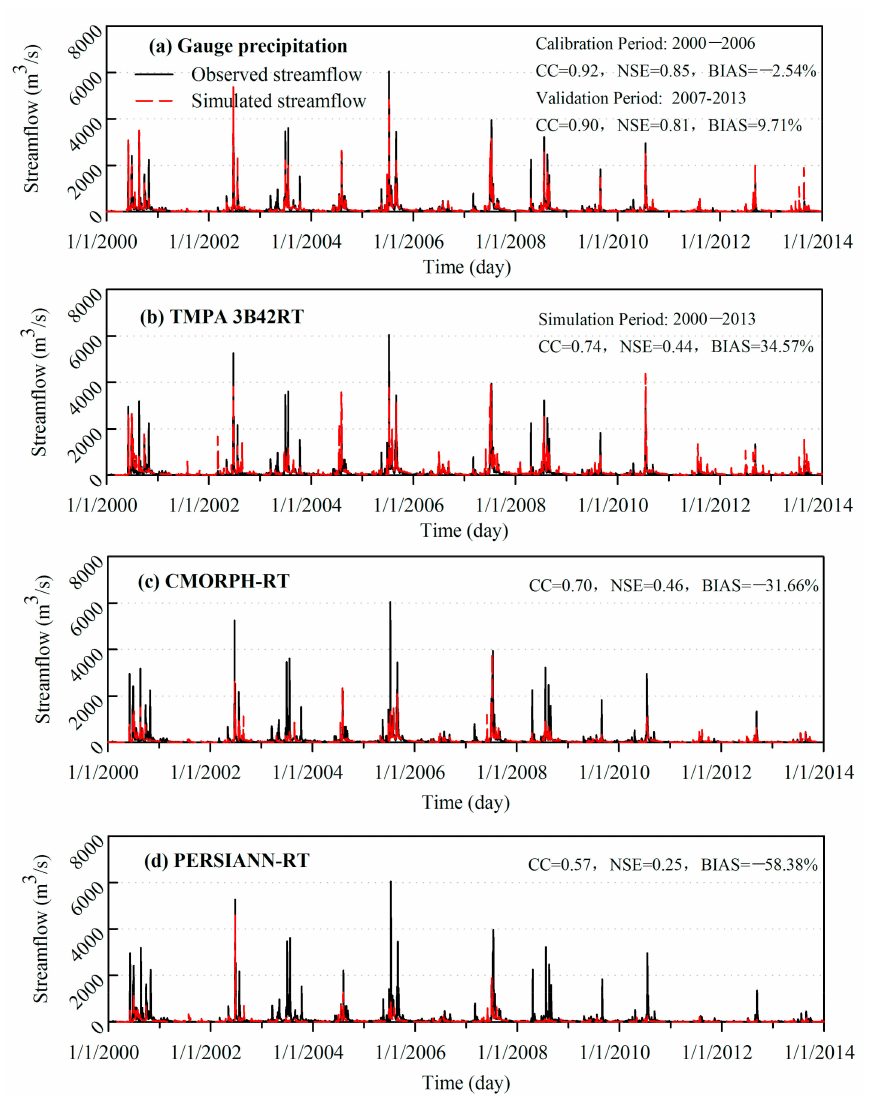
Figure 5. Observed and XAJ model-simulated daily streamflows from the rain gauge observations and the three real-time SPPs for ( a ) rain gauge precipitation; ( b ) TMPA 3B42RT; ( c ) CMORPH-RT and ( d )